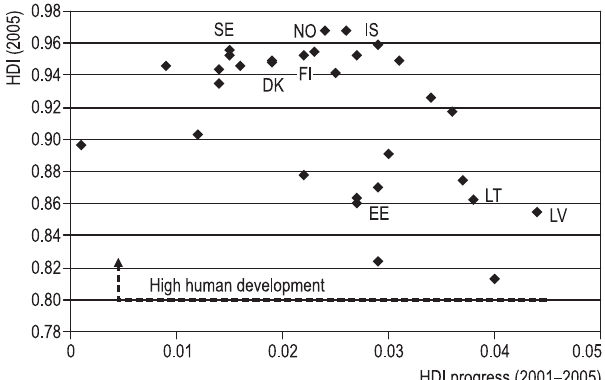
Fig. 15. Human Development Index; ranking positions of the EU countries